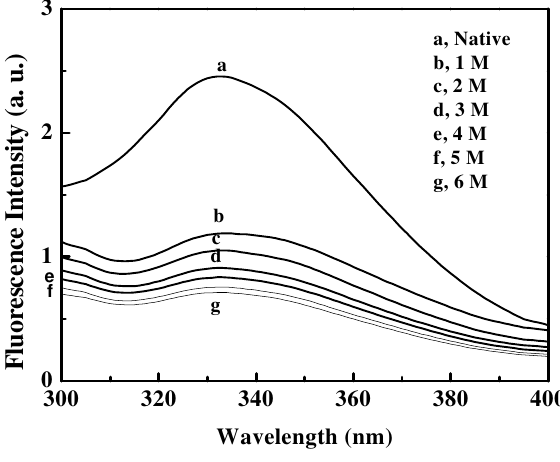
Figure 6 . Quenching of tryptophan fluorescence spectra of sLP in 1M GuHCl using various concentrations of KI (a) Native sLP (b) 1M GuHCl (c) 0.05M KI (d) 0.1 KI M (e) 0.15M KI (f) 0.20M KI (g) 0.25 M